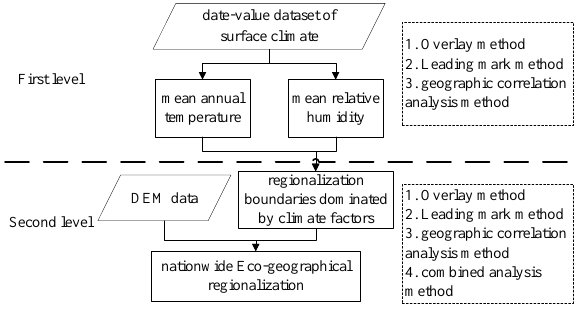
Figure 1. Process of nationwide Eco-geographic